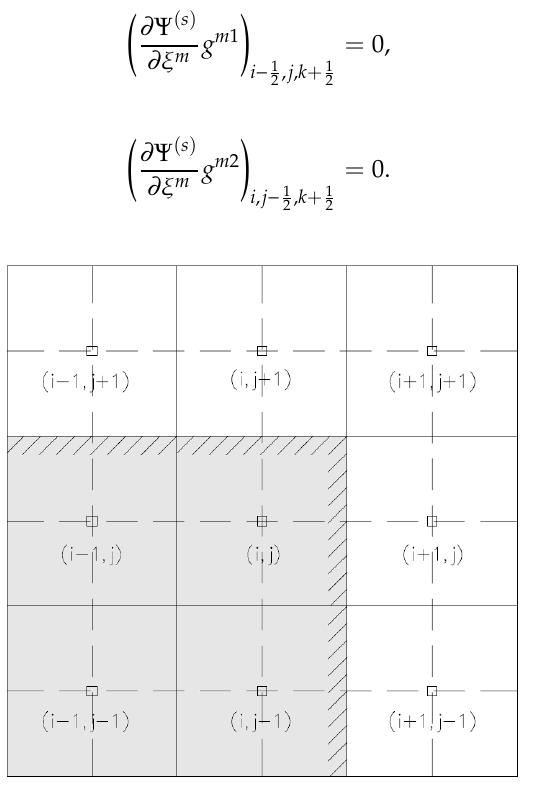
Figure 1. Cell stencil for an internal boundary defined by the cell interfaces between the calculation cells [ i + 1, j ] and [ i , j ] and between the calculation cells [ i , j + 1 ] and [ i , j ] , with k = − 1,0,1. Grey cells represent internal objects.